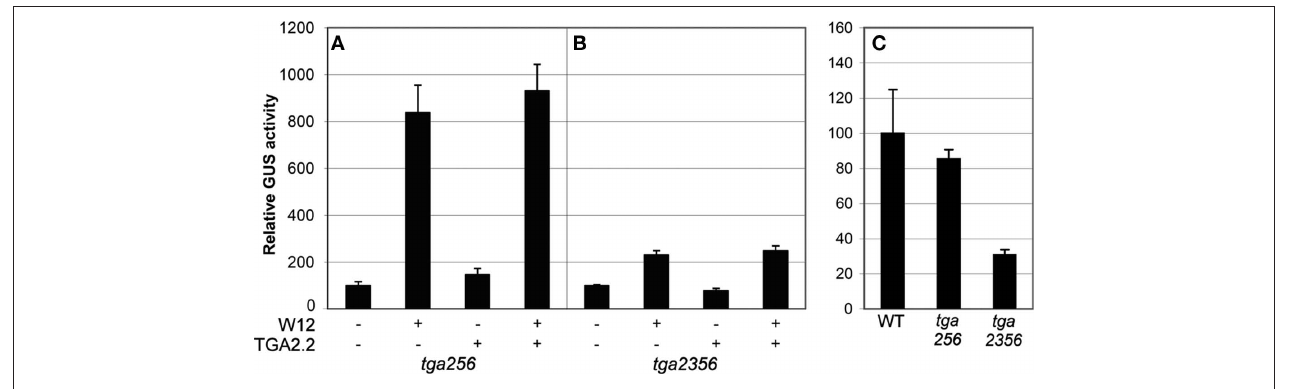
isolated from a TGA triple mutant ( tga256 ), a TGA quadruple mutant ( tga2356 ), or WT Col-0 (WT) as indicated below the panels. The bars represent the percentage of GUS activity from triplicate experiments relative to that of the protoplasts cotransfected with the corresponding promoter::GUS construct and empty vector control incubated overnight in W5 medium. Error bars represent the